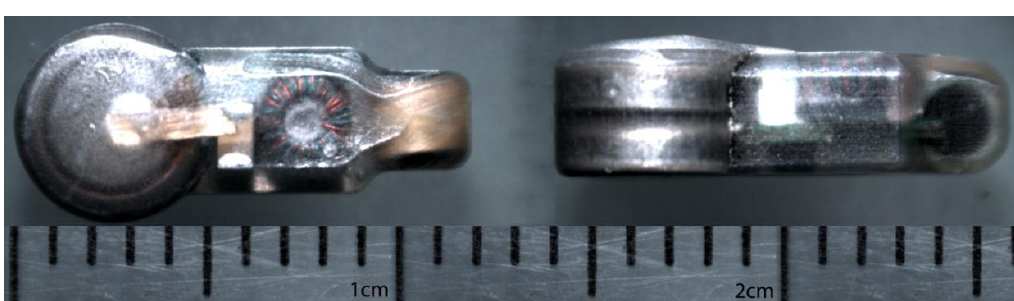
Figure 2. JSATS acoustic microtransmitter (Advanced Telemetry Systems, Inc., Isanti, MN,